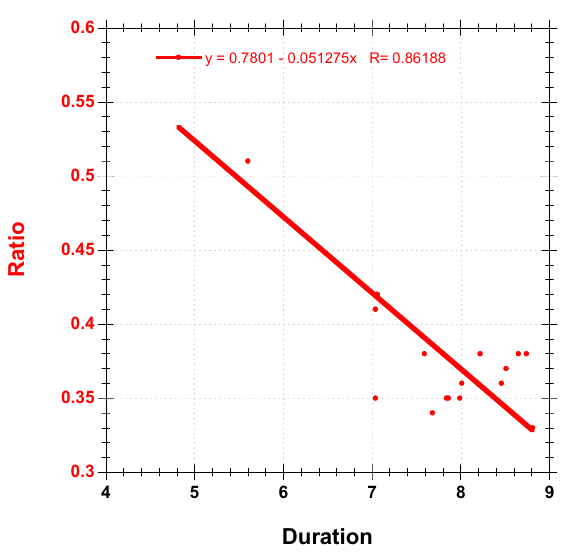
Figure 4. The annual flare ratio is a function of its duration (in minutes).